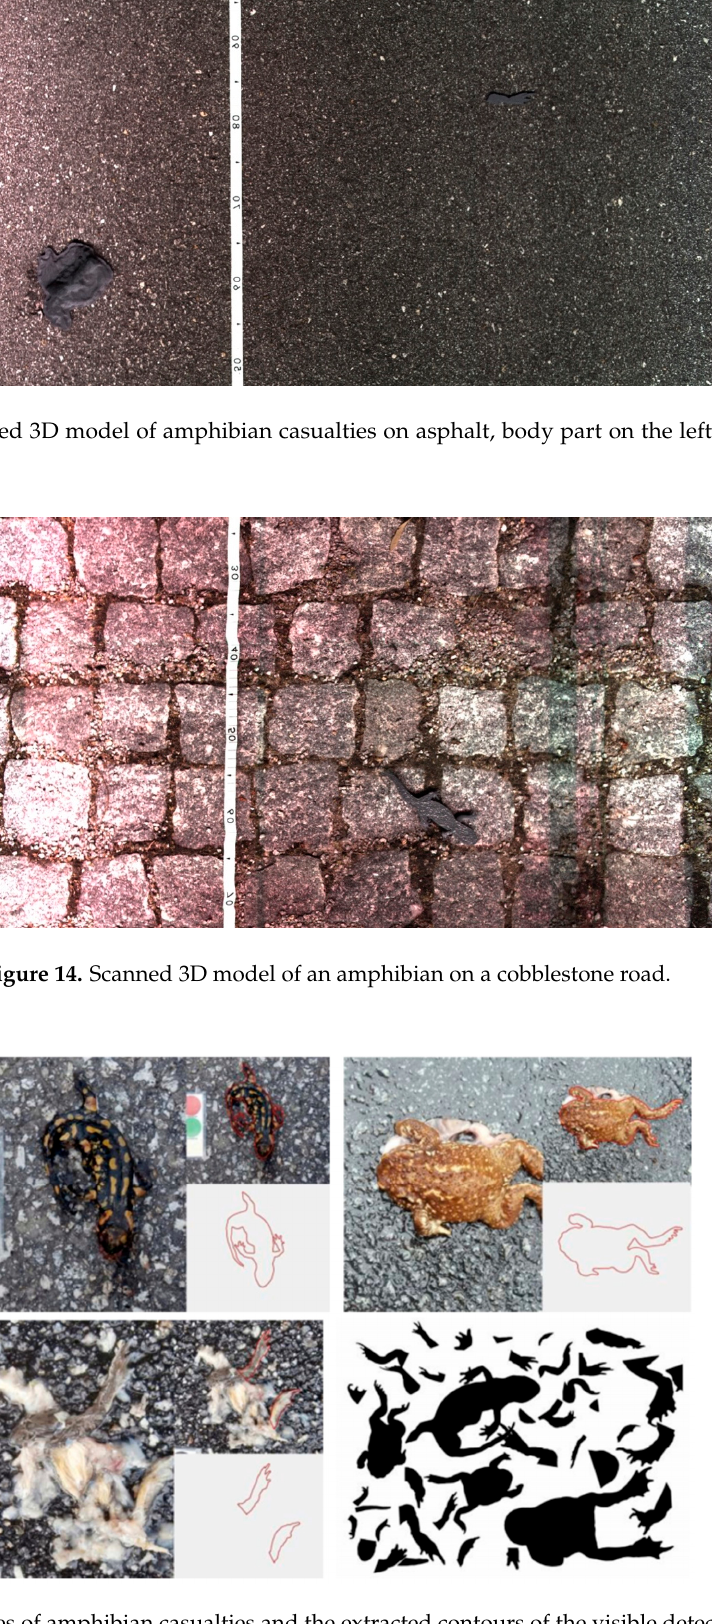
Figure 15. Pictures of amphibian casualties and the extracted contours of the visible detectable parts.